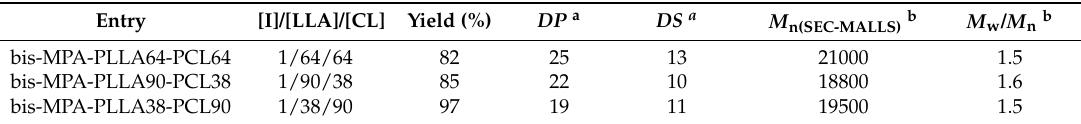
Table 1. Copolymerization of LLA and CL initiated by bis-MPA. Characterization of the synthesized branched